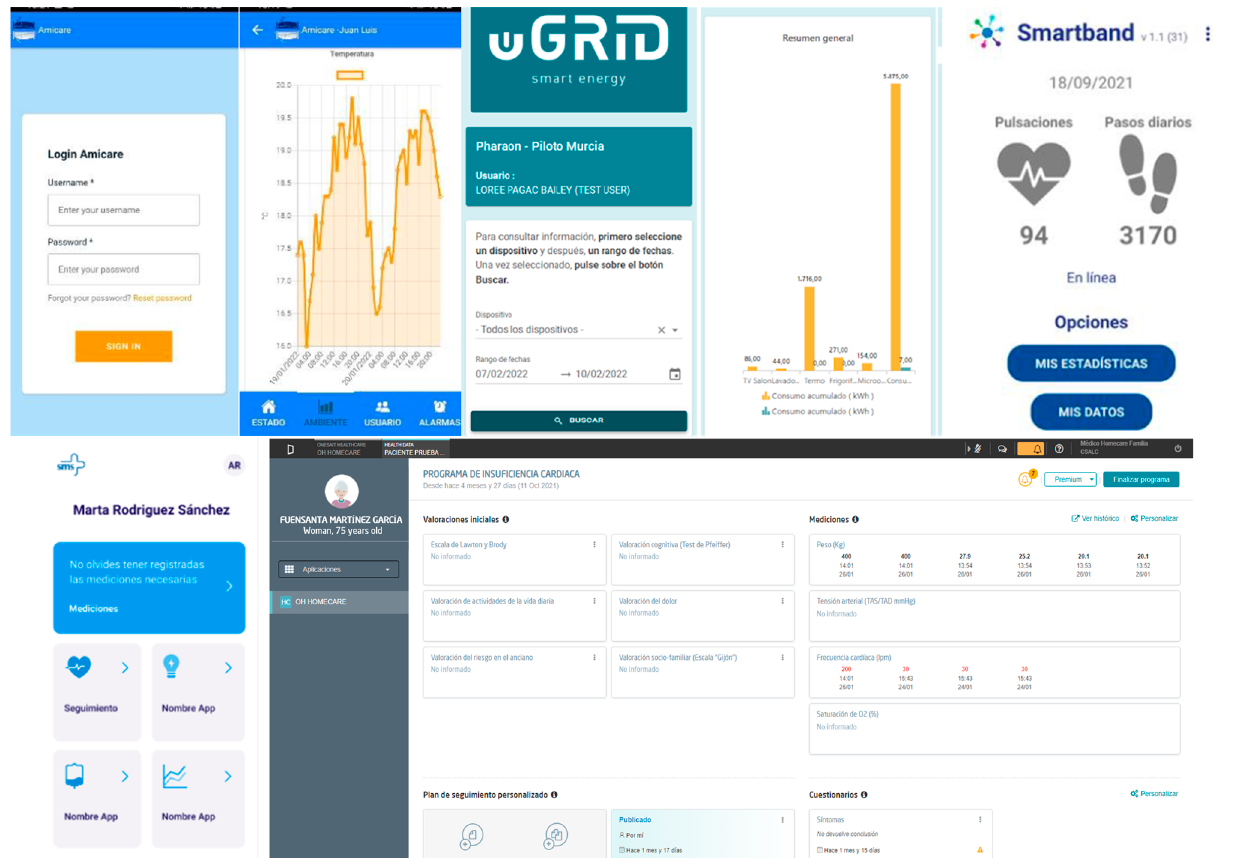
Figure 5. User interfaces of the technologies used in the Pharaon Murcia Pilot.